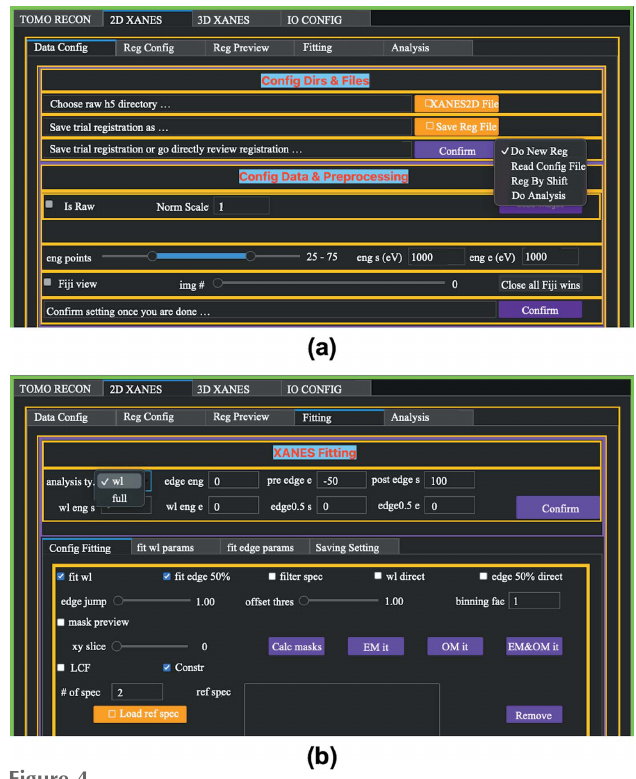
Figure 4 2D XANES GUI layout. ( a ) Analysis type and data configuration, and ( b ) XANES fitting